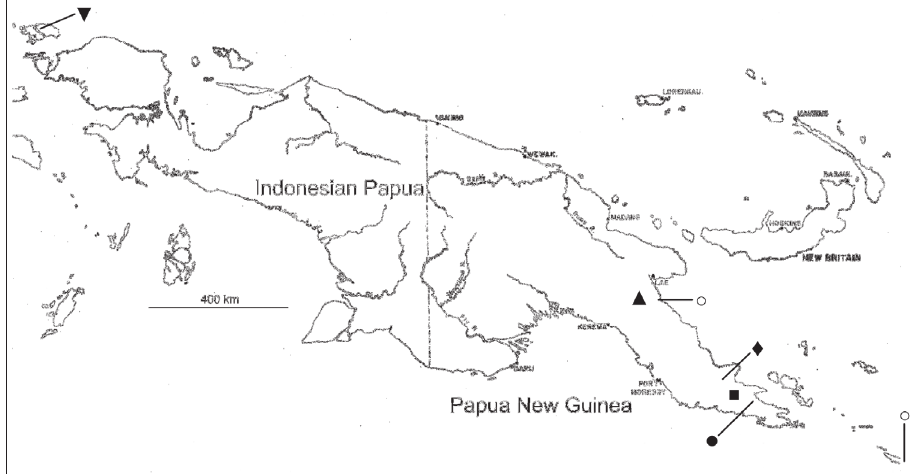
Figure 1. Island of New Guinea, showing localities of new species. Triangle ( ▲ ) = R. asekiensis ; Square ( ■ ) = R. daymanensis ; Diamond ( ♦ ) = R. makumak (at bottom of line); Closed circle ( ● ) = R. toratot (at top of line); Inverted triangle ( ▼ ) = R. waigeoensis (upper left, at bottom of line); Open circles ( ○ ) = R. sharpeana (left end of line [upper] and bottom of line [lower, on truncated eastern half of Tagula